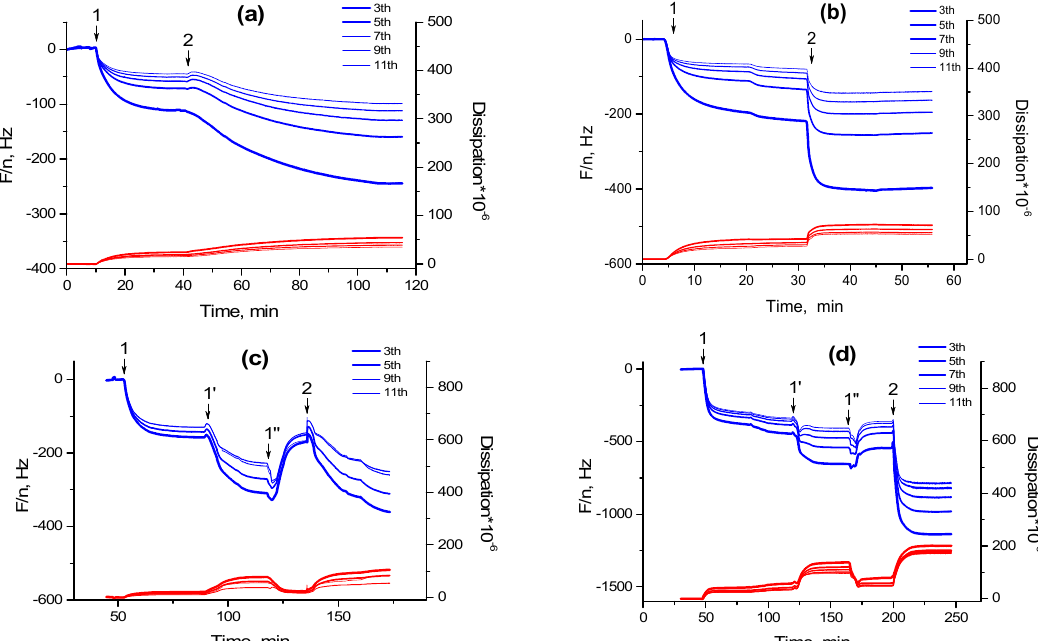
Figure 3. Normalized frequency, F/n , (blue lines) and dissipation, D , (red lines) shifts for gold-coated quartz crystal upon the adsorption of the P(NIPAM- co -APMA) microgel ( a , c ) or the P(NIPAM- co -DMAPMA) microgel ( b , d ), followed by the adsorption of ChO. Conditions: (Step 1) microgel adsorption from 1 g/L at pH 9.3 at 25 °C ( a , b ) or 50 °C ( c , d ); (Step 1 ′ ) temperature-induced swelling of the microgel film at pH 9.3 upon a temperature decrease from 50 to 25 °C ; (Step 1 ″ ) temperature-induced deswelling of the microgel film at pH 9.3 upon a temperature increase from 25 to 50 °C ; (Step 2) ChO uptake from the solution with the enzyme concentration of 0.4 g/L at pH 7.0 by the microgel film at 25 °C , in the case of the microgel film deposited at 50 °C, the enzyme uptake takes place simultaneously with microgel swelling upon a temperature jump from 50 to 25 °C (‘spongelike’ adsorption).